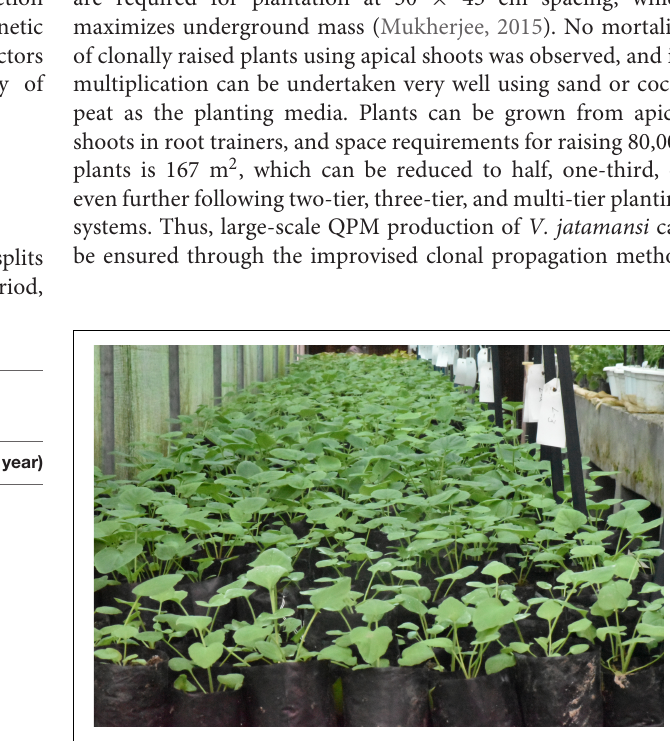
FIGURE 7 | Clonally raised plant nursery of Valeriana jatamansi